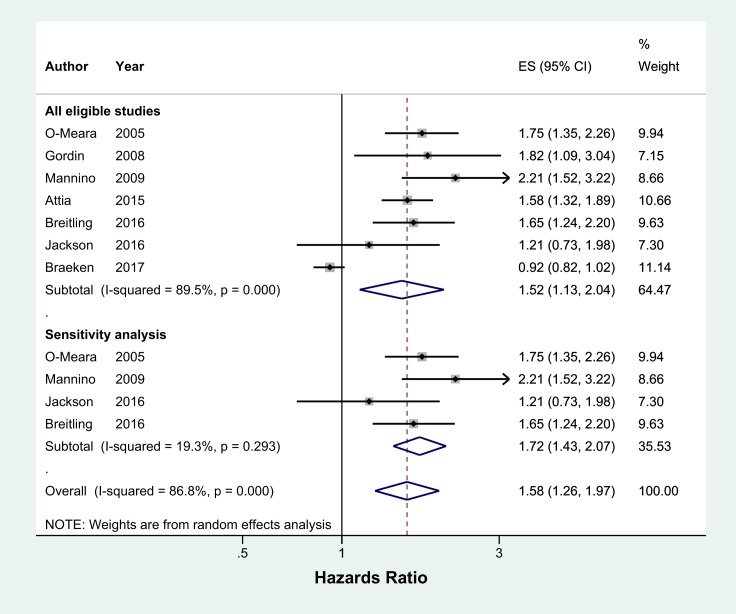
Meta-analysis of incidence of community acquired pneumonia in current smokers relative to never smokers (Hazards Ratio).Grey box = effect estimates from single studies. Diamond = pooled result with confidence interval. Vertical line at ‘1’ on the x-axis is the line of no effect. Weight (in %) = influence an individual study had on the pooled result.